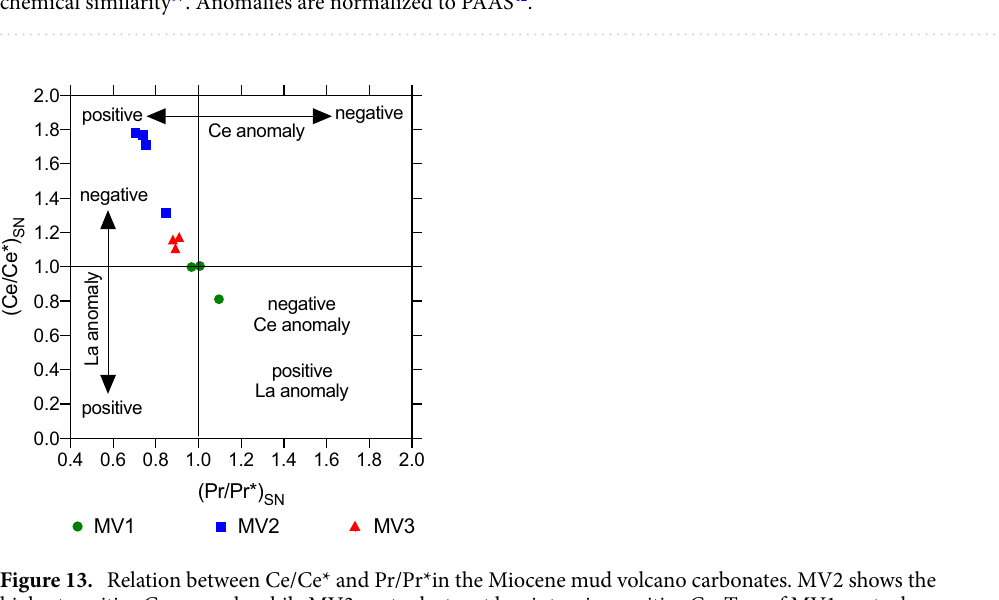
Table 3. Concentrations (ppm) of rare earth elements, Yttrium, Thorium and Uranium in the sub-samples of carbonate rocks from Miocene-age mud volcano outcrop. Y is inserted between Dy and Ho due to the chemical similarity 97 . Anomalies are normalized to PAAS 42 .